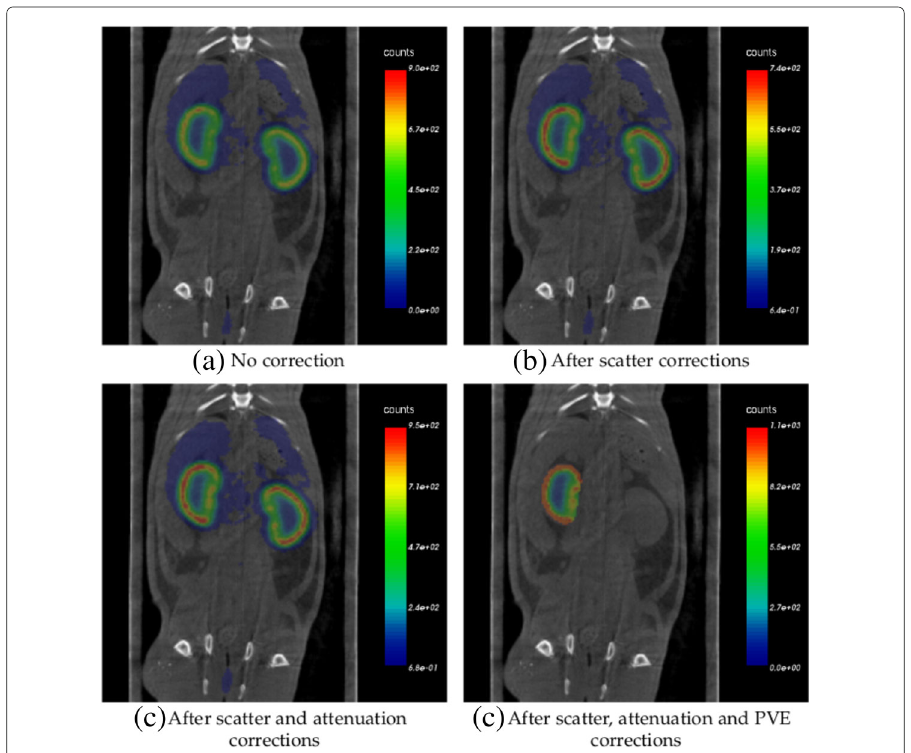
Fig. 5 Examples of in vivo images. Examples of in vivo images with no corrections( a ), after only scatter corrections( b ), after scatter and attenuation corrections( c ), and after scatter, attenuation and PVE corrections ( d ). The activity outside the target VOI has been masked out during PVE corrections